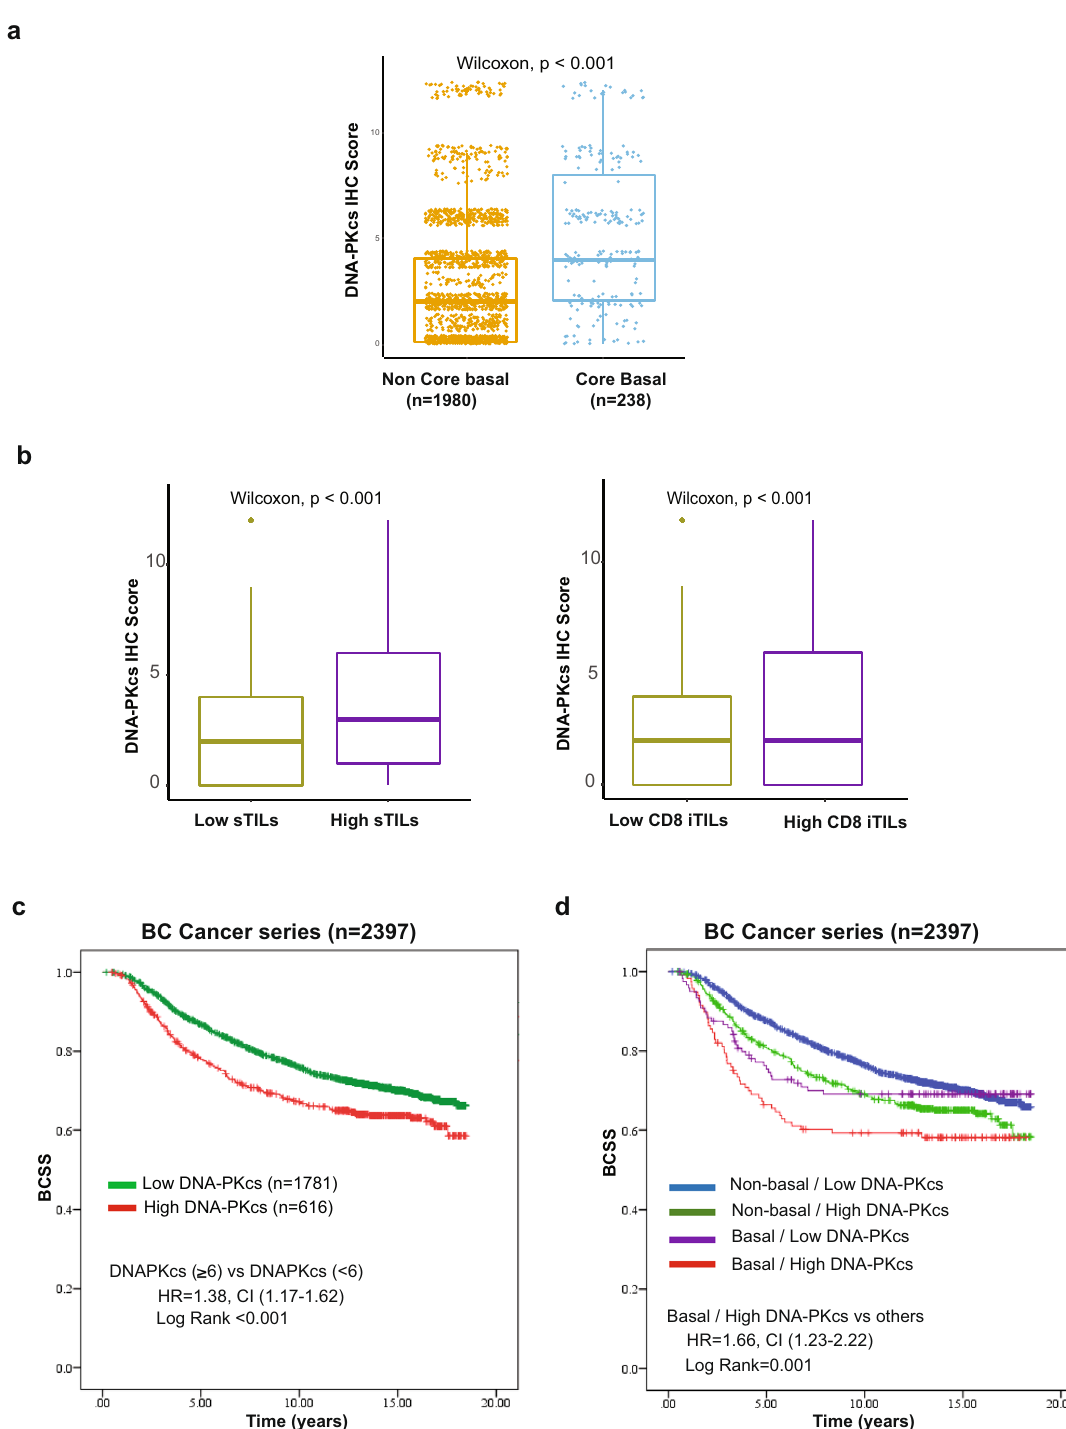
Fig. 3 Analysis of DNA-PKcs expression in the BC Cancer series ( n = 2401). a Boxplots showing the expression levels of DNA-PKcs by IHC according to “ core basal status ” . High expression of DNA-PKcs is associated with the core basal IHC phenotype ( p -value < 0.001). Core basal is de fi ned as ER-, PR-, Her2- and [EGFR + or CK5 + ]. The median (center bar), and the third and fi rst quartiles (upper and lower edges, respectively) are shown. b Boxplots showing the expression levels of DNA-PKcs by IHC according to “ sTILs ” and “ CD8 + iTILs ” categories. High expression of DNA-PKcs is associated with high expression of sTILs and high expression of CD8 + iTILs. The median (center bar), and the third and fi rst quartiles (upper and lower edges, respectively) are shown. c Kaplan – Meier curves for BCSS in the BC Cancer series according to DNA- PKcs IHC expression status. d Kaplan – Meier curves for BCSS strati fi ed according to core basal status and DNA-PKcs IHC expression. Core basal tumors with high DNA-PKcs expression are associated with the worst BCSS. Abbreviations: IHC immunohistochemistry, sTILs stromal tumor- in fi ltrating lymphocytes, iTILs intraepithelial tumor-in fi ltrating lymphocytes, BCSS breast cancer-speci fi c